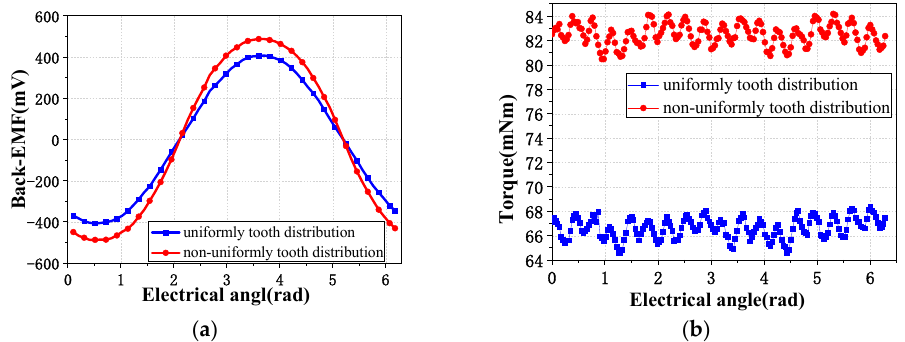
Figure 14. Comparison of airgap flux density by FEM: ( a ) flux density waveform; ( b ) spectra of FFT.